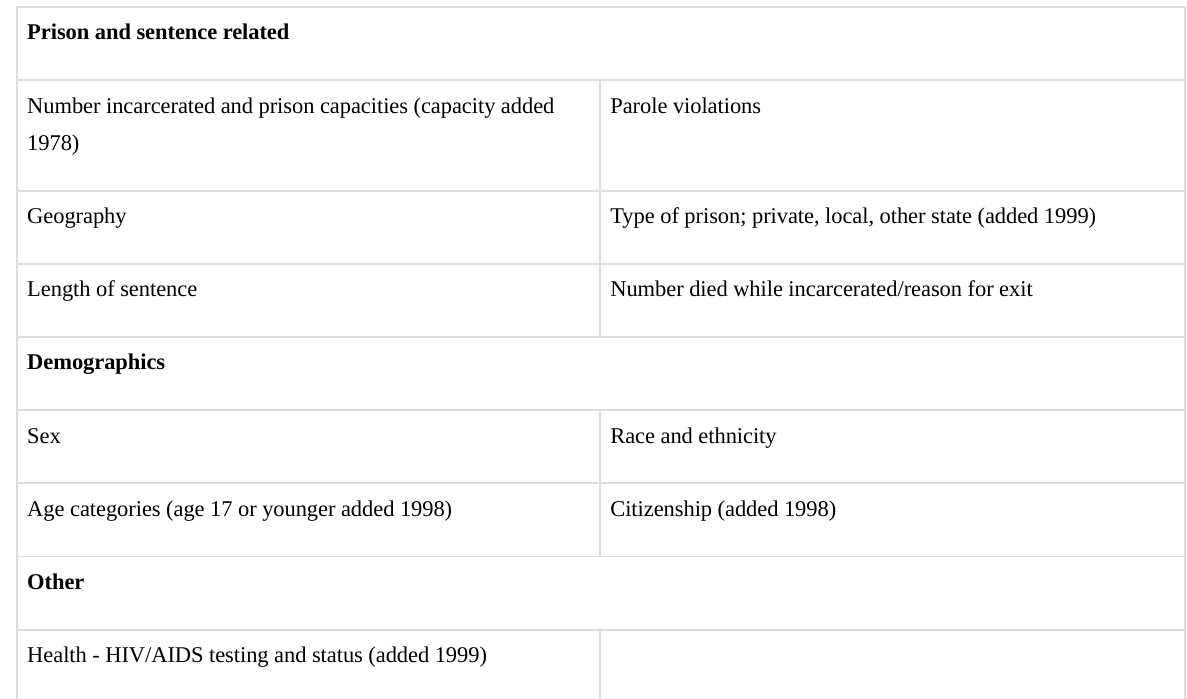
Table 2. Questions related to prisons on the national prisoner statistics 1926–2018.